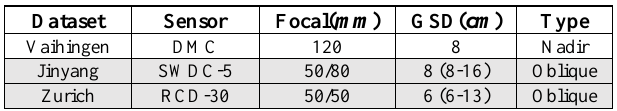
Table 1. Description of the test